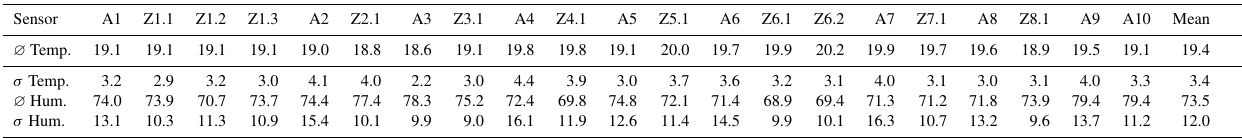
Table 1. Means and standard deviations of temperature [ ◦ C] and relative humidity [%] at the NETATMO sensors for the 11d period in August 2021. Sensor